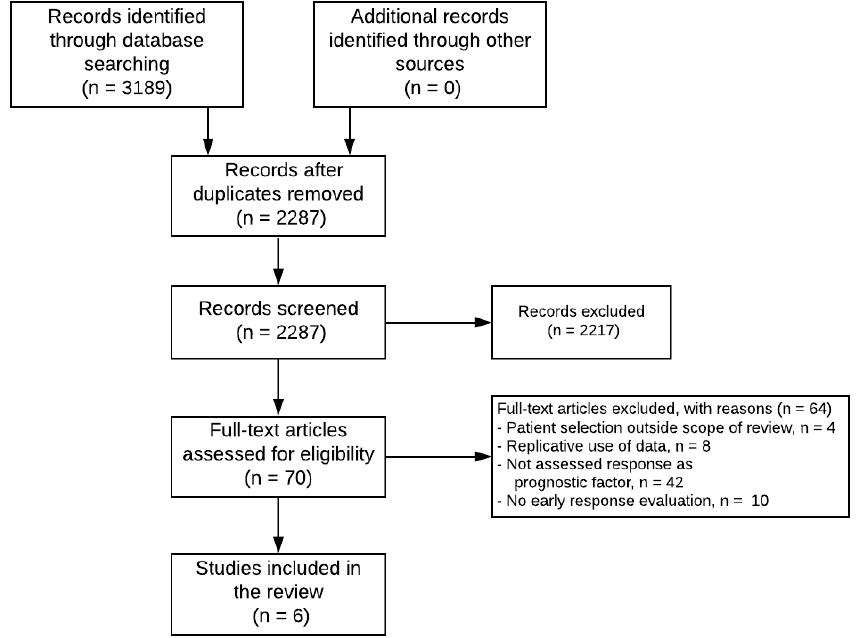
Figure 1. Flowchart of study inclusion.